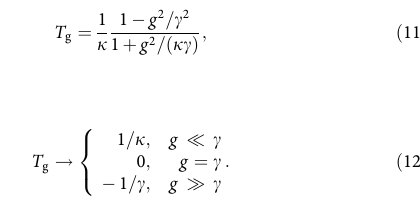
the anti-resonance depend solely on the atomic properties, while we have shown that the DIT resonance mirrors the avoided crossing of the normal modes. This makes DIT attractive for the detection of coherence in systems where strong coupling is either not feasible or undesired.